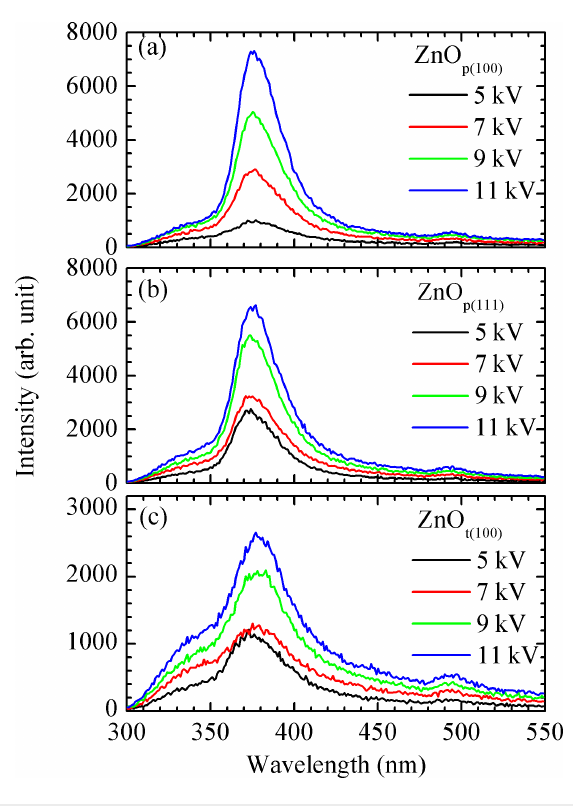
Figure 7: Cathode luminescence spectra of the samples (a) ZnO p(100) , (b) ZnO p(111) , and (c) ZnO t(100) with the excitations of 5, 7, 9, and 11 kV electron voltages at room